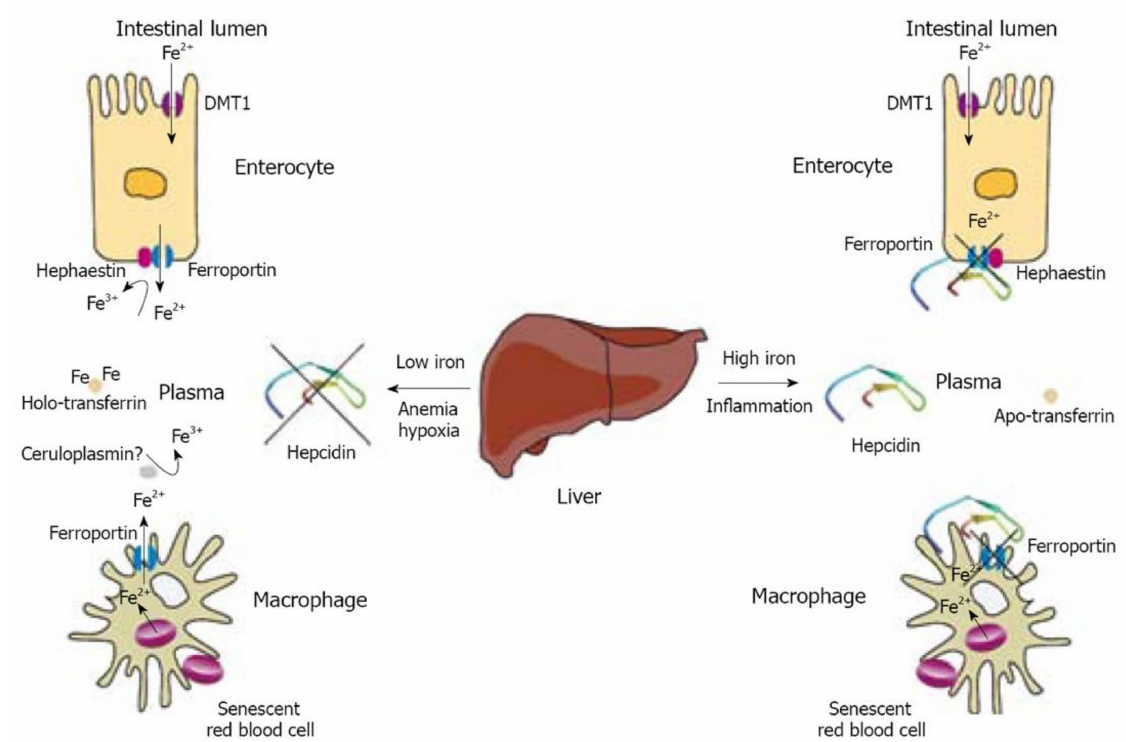
Figure 2. Regulation of iron efflux from enterocytes and macrophages by hepcidin. Reproduced with permission after Pantopoulos K. et al., 2008